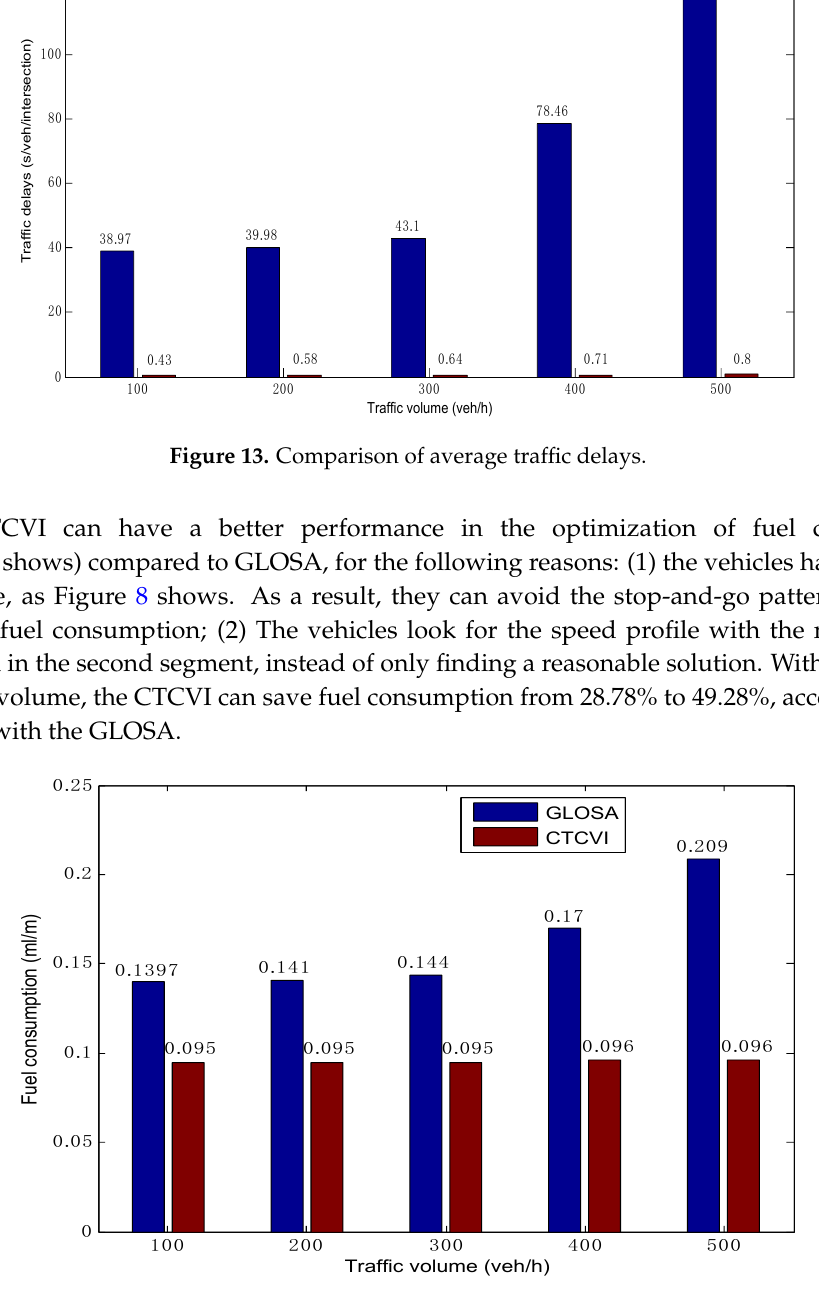
Figure 14. Comparison of average fuel